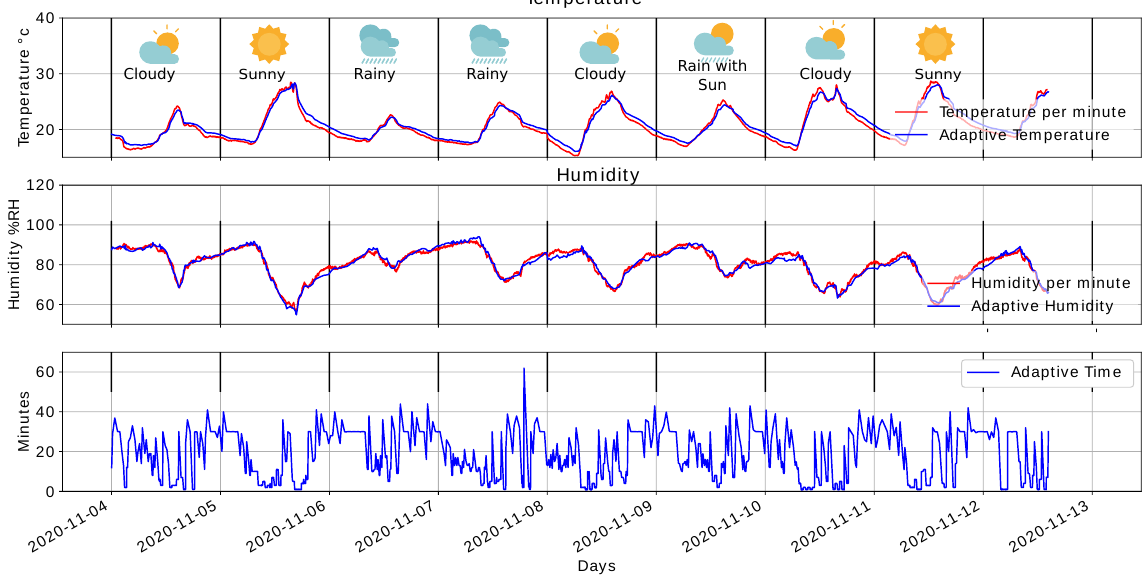
Figure 23. Result for different day